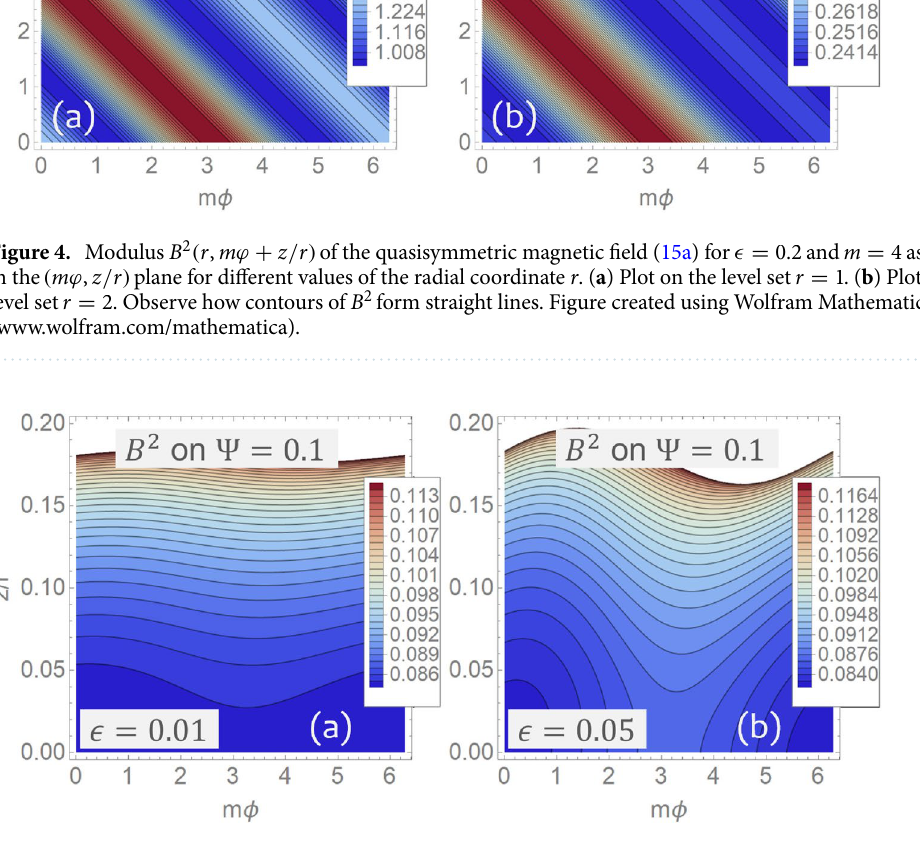
Figure 5. Modulus B 2 ( r (� , z / r , η) , η) with η = m ϕ + z / r of the quasisymmetric magnetic field (15a) for r 0 = 3 , m = 4 and E = 0.7 as seen in the ( m ϕ , z / r ) plane corresponding to (cid:31) = 0.1 . ( a ) The case ǫ = 0.01 . ( b ) The case ǫ = 0.05 . Notice that white regions in the plot reflect the fact that for given values of (cid:31) and ϕ the range of z is bounded. Figure created using Wolfram Mathematica 12.2